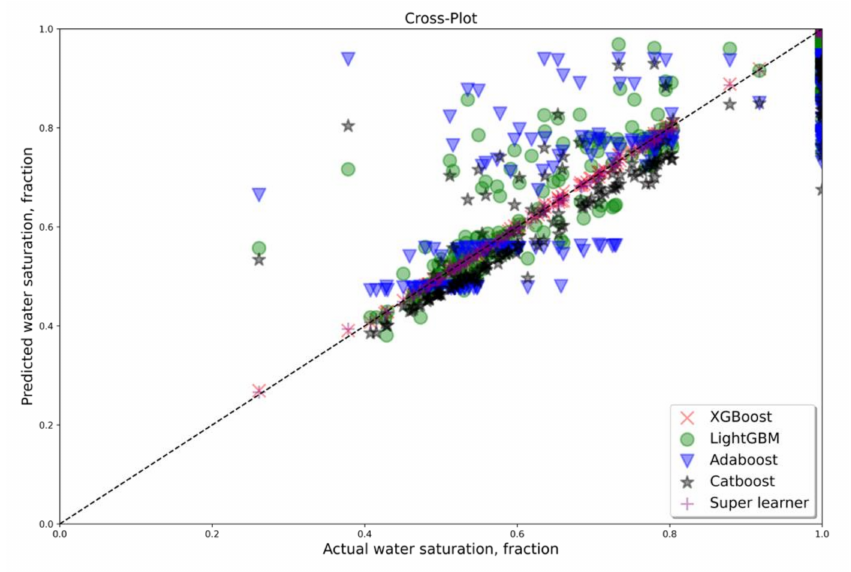
Figure A1. Cross plot for water saturation prediction results by different algorithms (Well 1).